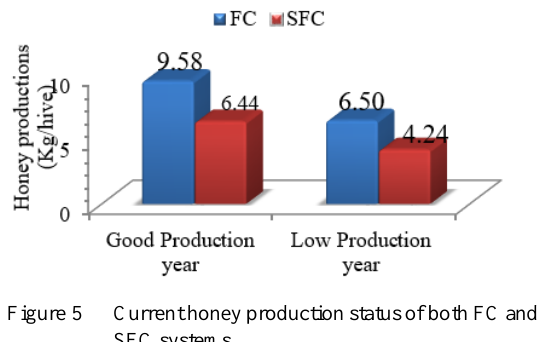
Current honey production status of both FC and SFC